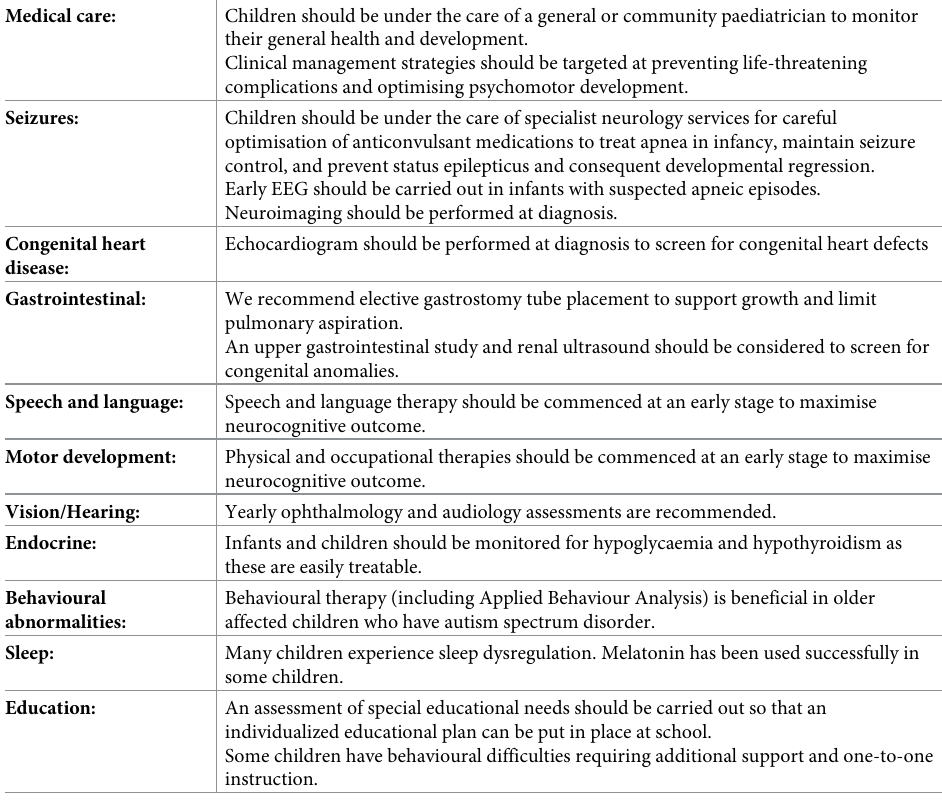
Table 3. SNIP1 -related disorder clinical advice and